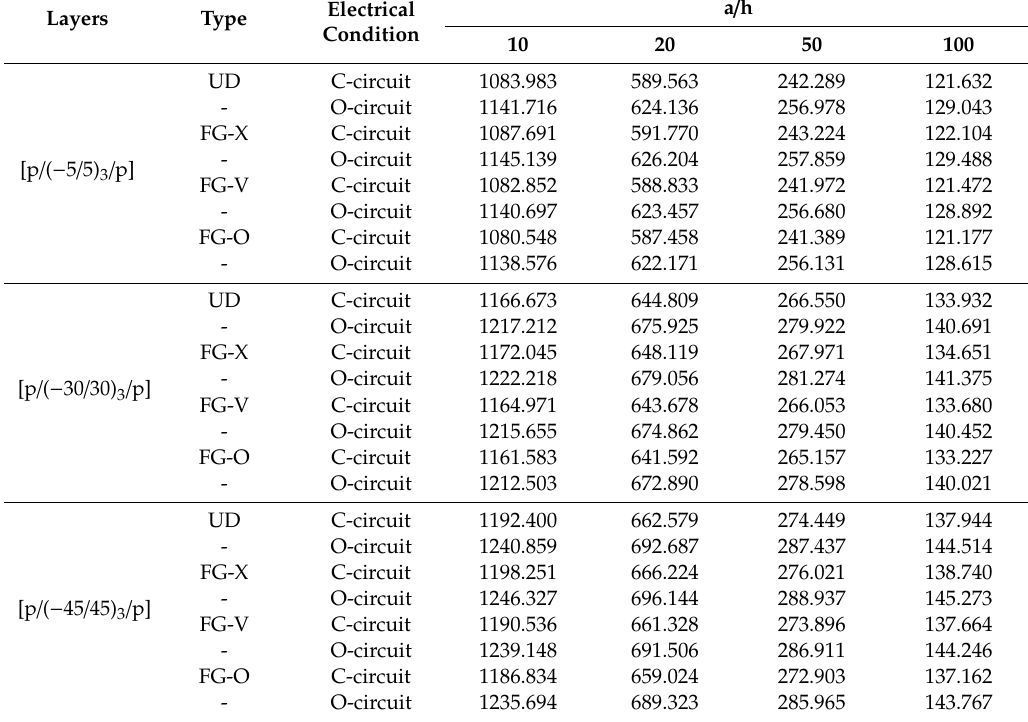
Table 9. The fundamental natural frequencies ω (Hz) of anti-symmetric angle-ply [p / ( − θ / θ ) 3 /